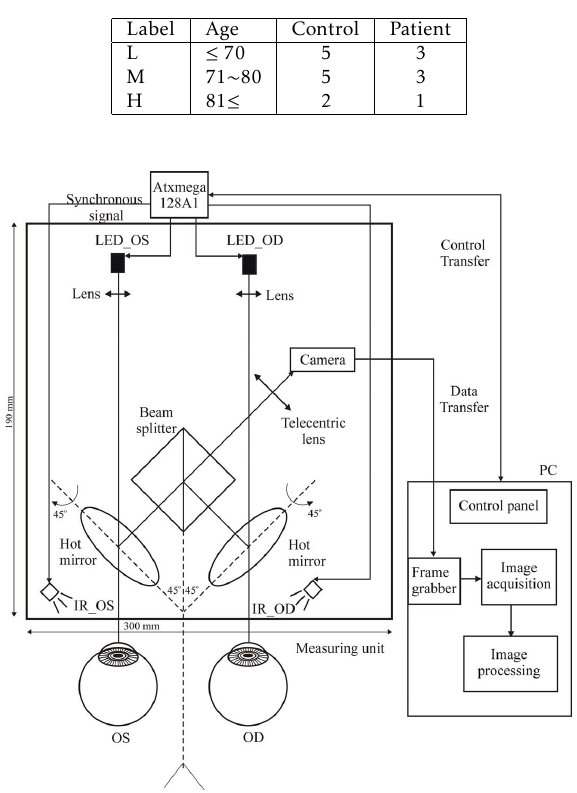
Table 1. Number of subjects by age